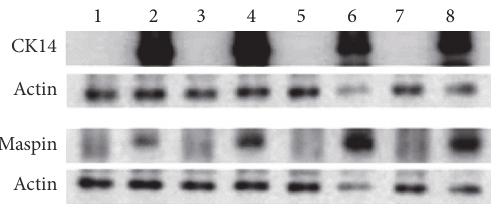
Figure 6: Differentiation induction of Type I HBECs developed in the K-NAC medium by cholera toxin into Type II HBECs.